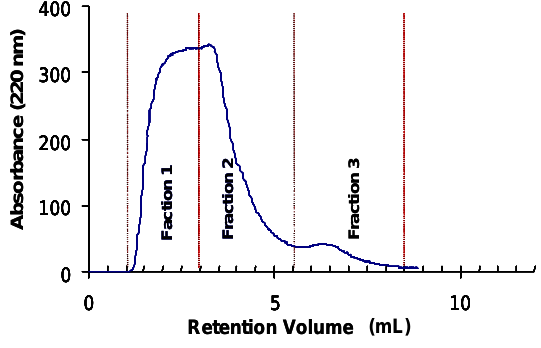
Figure 5. Analysis of the carbohydrate specificity of tepary bean hemagglutinin by lectin affinity chromatography. A glycopeptide mixture purified from thermolysin-treated thyroglobulin was applied to a column with a resin containing immobilized PAA. The glycopeptides were eluted in three fractions. Fraction 1 contains the unbound glycopeptides. Fractions 2 and 3 are the fractions that were retarded by the lectin column and that therefore have affinity for the lectin. Carbohydrate composition of these fractions is presented in Table 8. The proposed structure of the oligosaccharide with the highest affinity with the tepary bean lectin is presented in Figure 6.